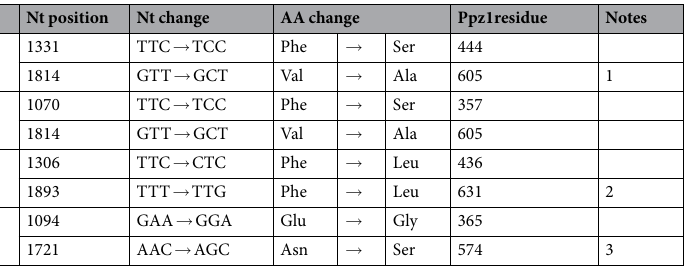
Table 2. Mutations affecting the catalytic domain of Ppz1 that result in changes in two amino acids. (a) Identical to clone 144. (b) Identical to clones 85, 100 and 140. These clones include also changes at nucleotides 1806 (GCT to GCC) and 1845 (GAT to GAC) that do not modify the encoded amino acid. (c) Identical to clones 138, 153 and 168. (1) Same mutation than clone 120 (also found in clones 85, 100, 140, and 144). (2) Follows single amino acid mutation in clone 97. (3) Precedes single amino acid mutation in clone